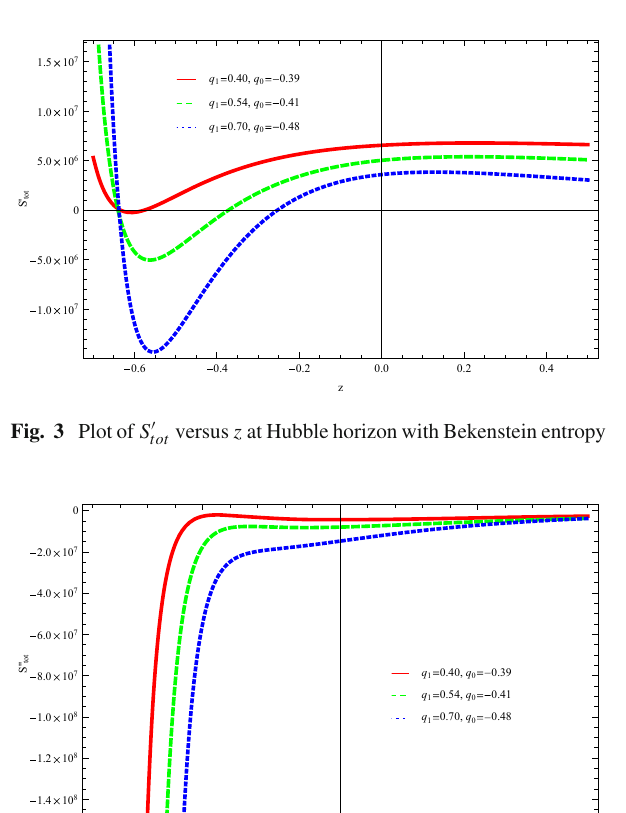
the same observational values of q o , q 1 and H o trajectories remains in positive direction at early, present and later epoch which confirms the stability condition i.e. v 2